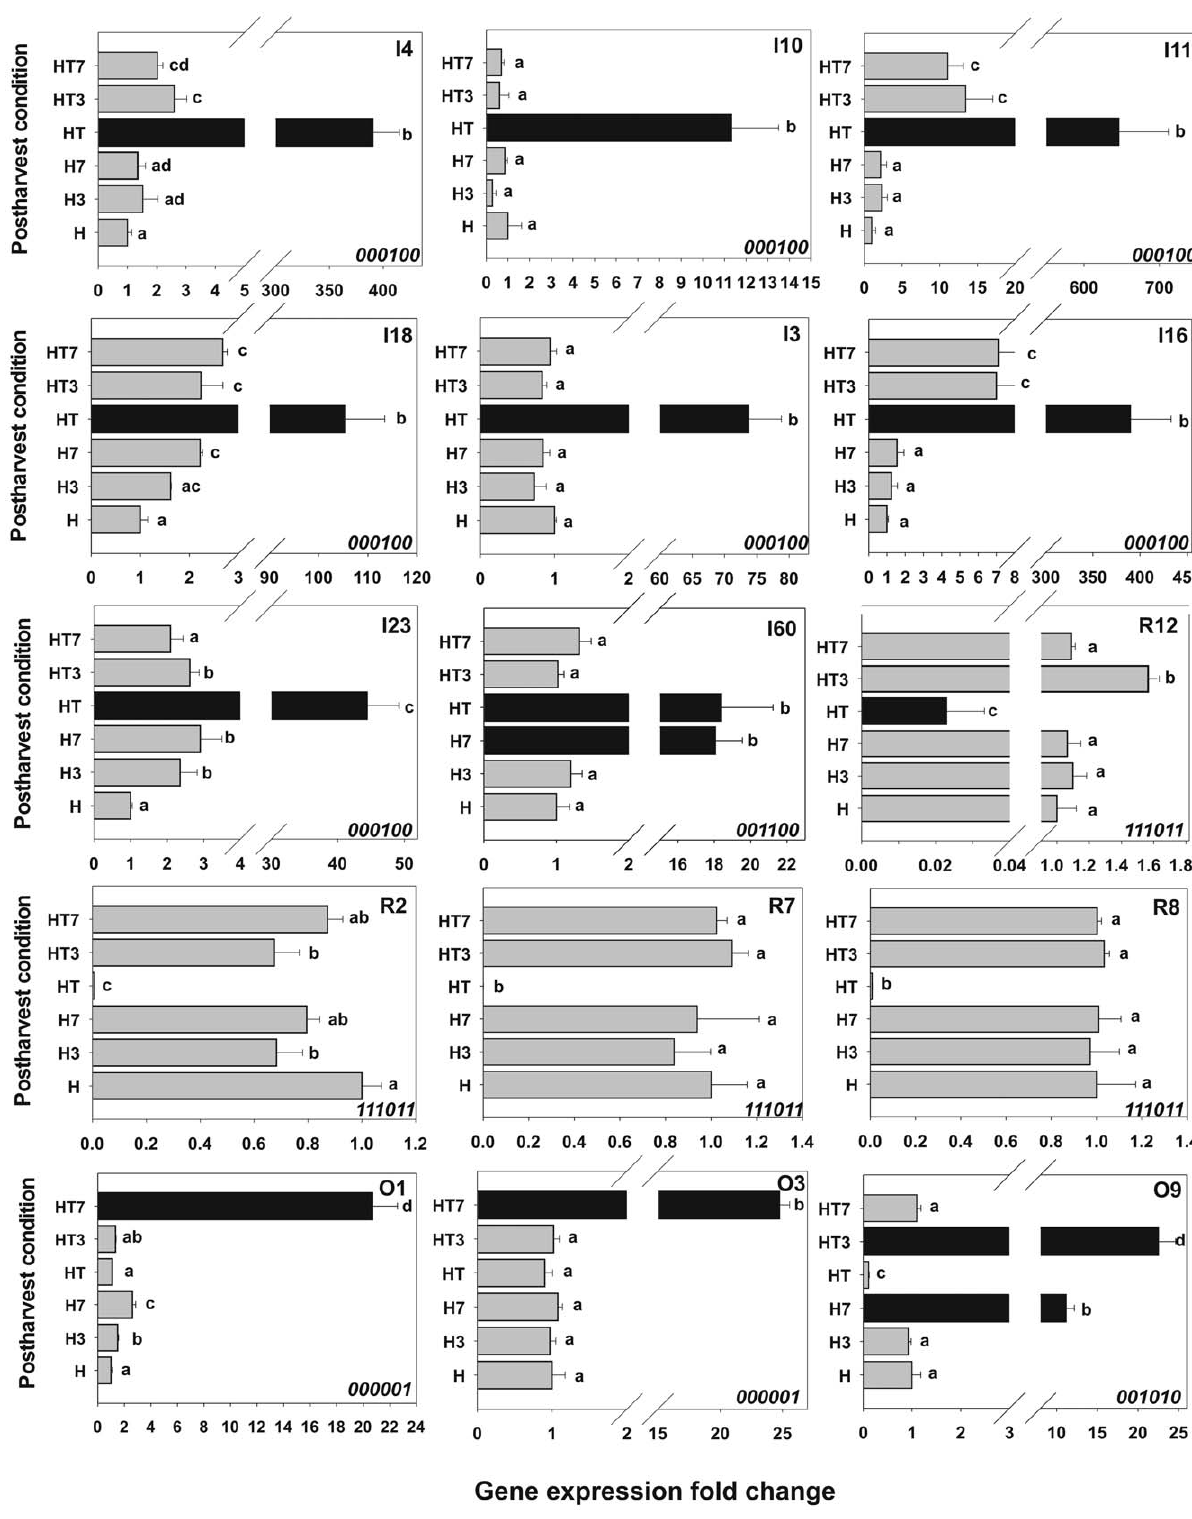
Figure 3. Validation of differentially expressed unigenes by qRT-PCR. The relative-to-harvest level of accumulation of the differentially expressed transcripts was determined in the different post-harvest conditions studied. Relative expression level indicated by black bars emphasized the presence-absent pattern of expression observed in the differential display experiments. Gene expression levels were normalized against Arabidopsis thaliana rad50 (gb|AF168748.1|AF168748). Bars with at least one equal letter mean no statistically significant difference ( a =0.05). The expression pattern code (Table 1) of each unigene is indicated on the bottom right corner of each graph.